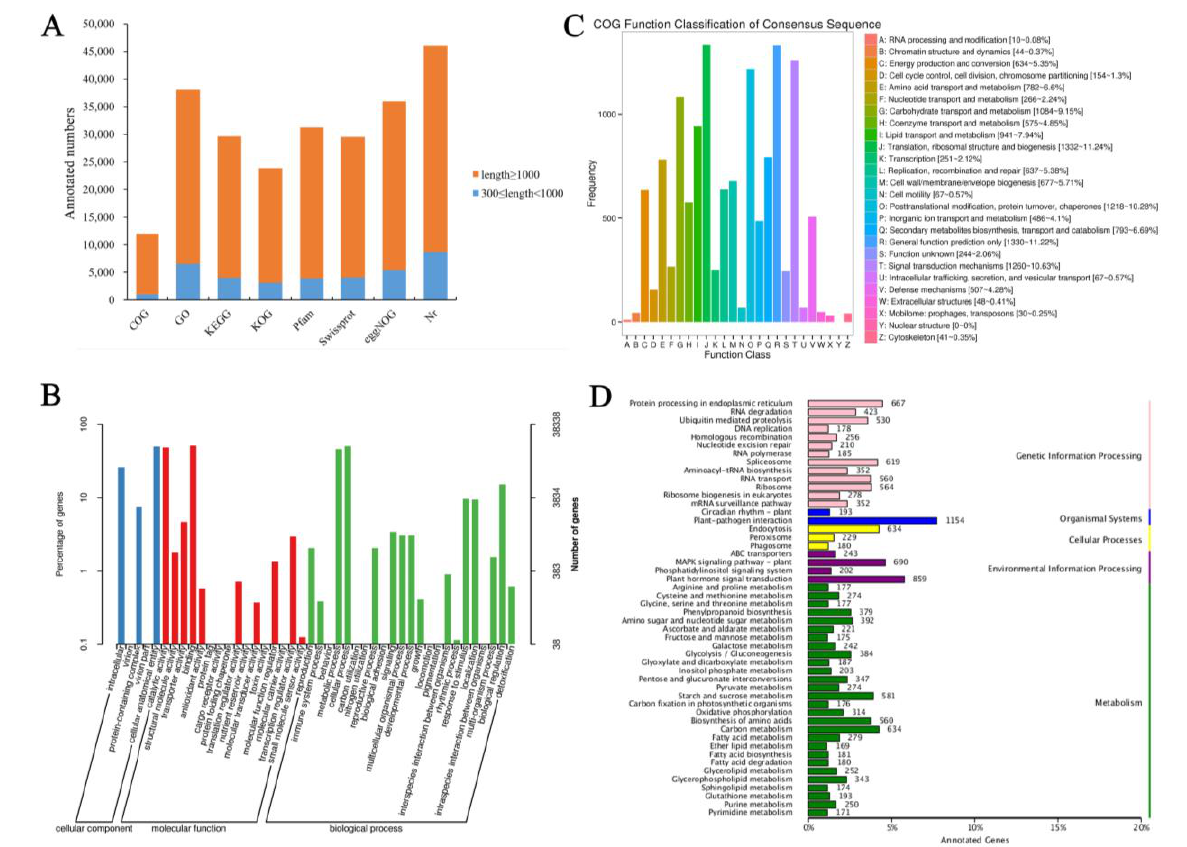
Figure 2. All genes are annotated in the public databases of CVW and CVT. ( A ) Statistics on the number of unigenes in different databases. ( B ) GO terms of unigenes. ( C ) COG function classification of unigenes. ( D ) KEGG pathways significantly enriched in unigenes.